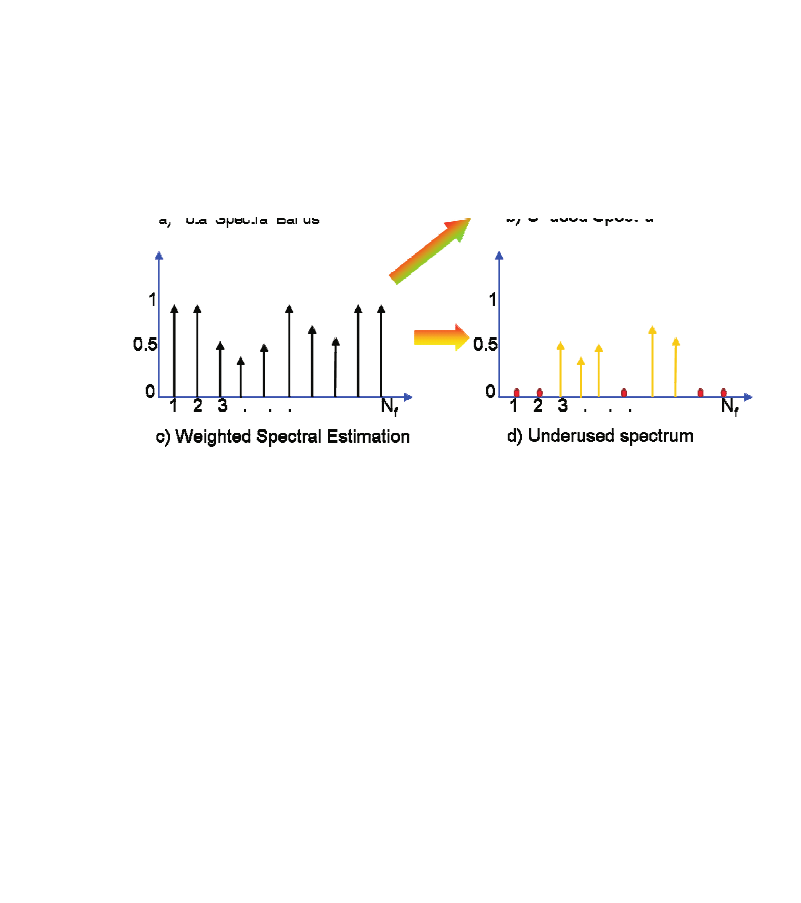
Figure 50. Spectrum parsing using weighted spectrum estimation in realization of SD- SMSE waveform.